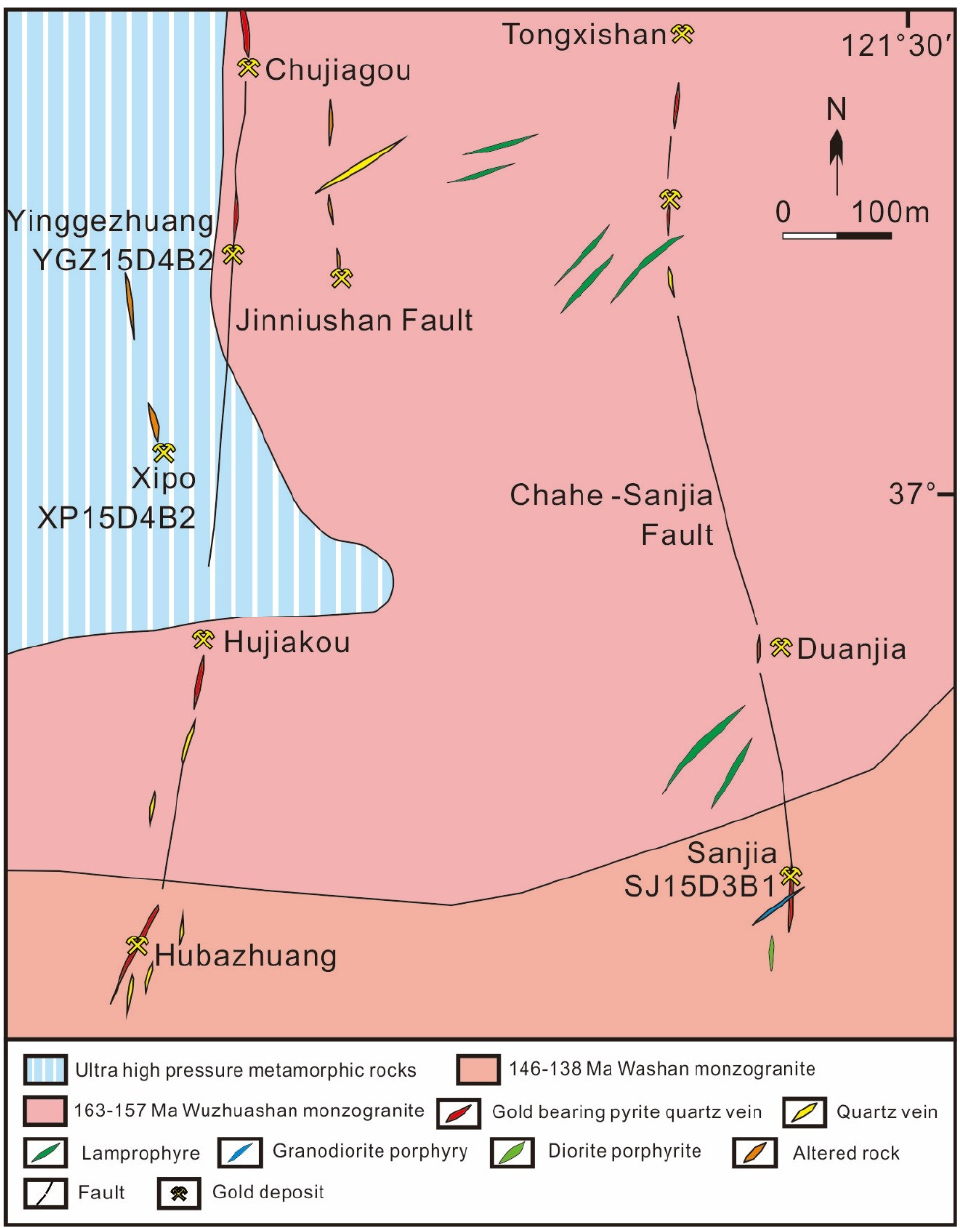
Figure 2. Geological map of the study area in the Muping–Rushan gold belt (adapted from [11]). The Yinggezhuang gold deposit (121°33 ′ 43 ″ –121°34 ′ 13 ″ E, 37°2 ′ 19 ″ –37°3 ′ 6 ″ N) is lo- cated 14 km northeast of Rushan City with an area of 0.85 km 2 and a proven reserve of 9 t. The Jinniushan fault is the ore-controlling fault (Figure 2), and its general trend is North– South dipping to the East with a dip angle of 51°–88°. The orebodies occur at depths be- tween +163 m and − 410 m, strike north–south, and are up to 50–450 m long along the strike and up to 520 m long along the dip. The grade is typically 1.54 to 19.00 g/t. The ore is mainly the quartz sulfide vein and beresite types. Amphibolite and gneiss occur as